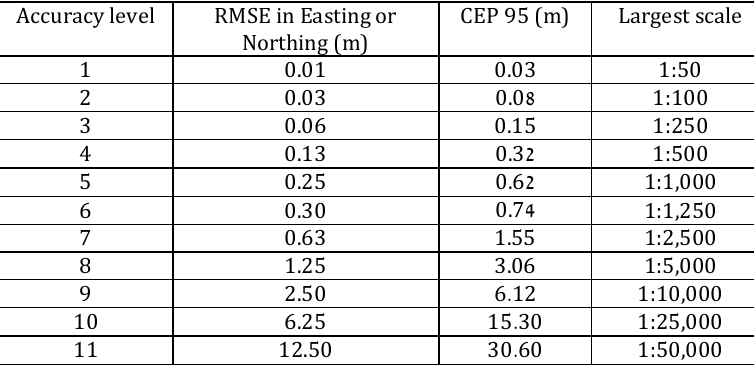
Table 1: Accuracy levels for mapping